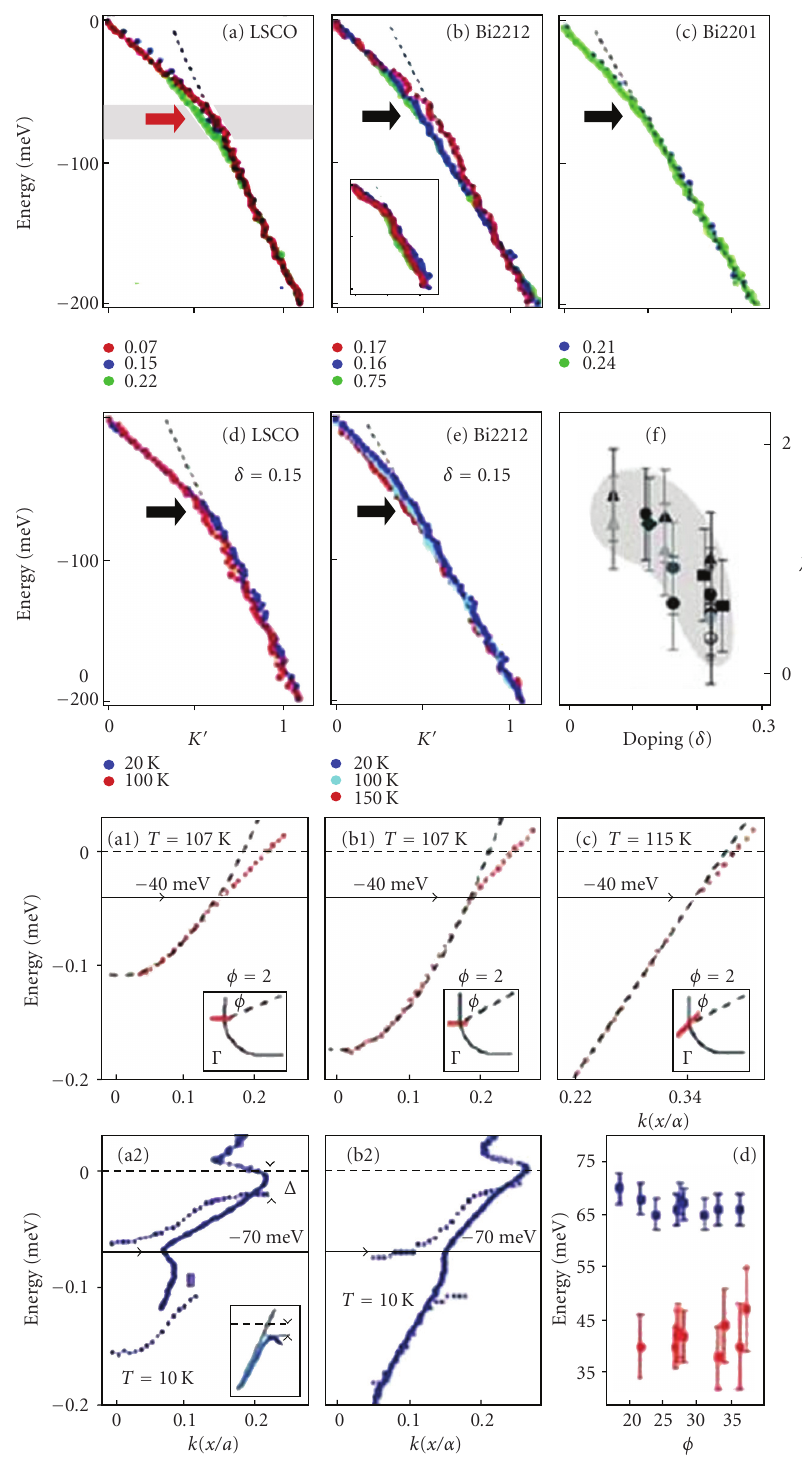
Figure 14: (top) Quasiparticle dispersion of Bi 2212, Bi 2201, and LSCO along the nodal direction, plotted versus the momentum k for (a)–(c) di ff erent doping, and (d)-(e) di ff erent T ; black arrows indicate the kink energy; the red arrow indicates the energy of the q = ( π ,0) oxygen stretching phonon mode; inset of (e) shows T -dependent Σ (cid:6) for optimally doped Bi 2212; (f) shows doping dependence of the e ff ective coupling constant λ (cid:6) along (0,0) − ( π , π ) for the di ff erent HTSC oxides. From [91]. (bottom) Quasiparticle dispersion E ( k ) in the normal state (a1, b1, c), at 107 K and 115 K, along various directions φ around the antinodal point. The kink at E = 40meV is shown by the horizontal arrow. (a2 and b2) are E ( k ) in the superconducting state at 10 K with the shifted kink to 70meV. (d) kink positions as a function of φ in the antinodal region. From